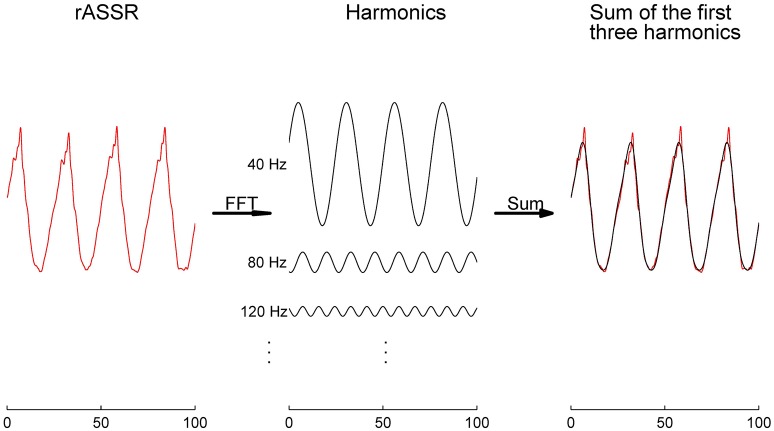
The rASSR approximation by the first three harmonics. The four-cycle rASSR in red was plotted in the left panel. By FFT, the rASSR was decomposed to a number of harmonics (black in the middle panel) at integral multiples of 40 Hz. In the right panel, the summation of the first three harmonics (in black) approximates the original rASSR (in red).